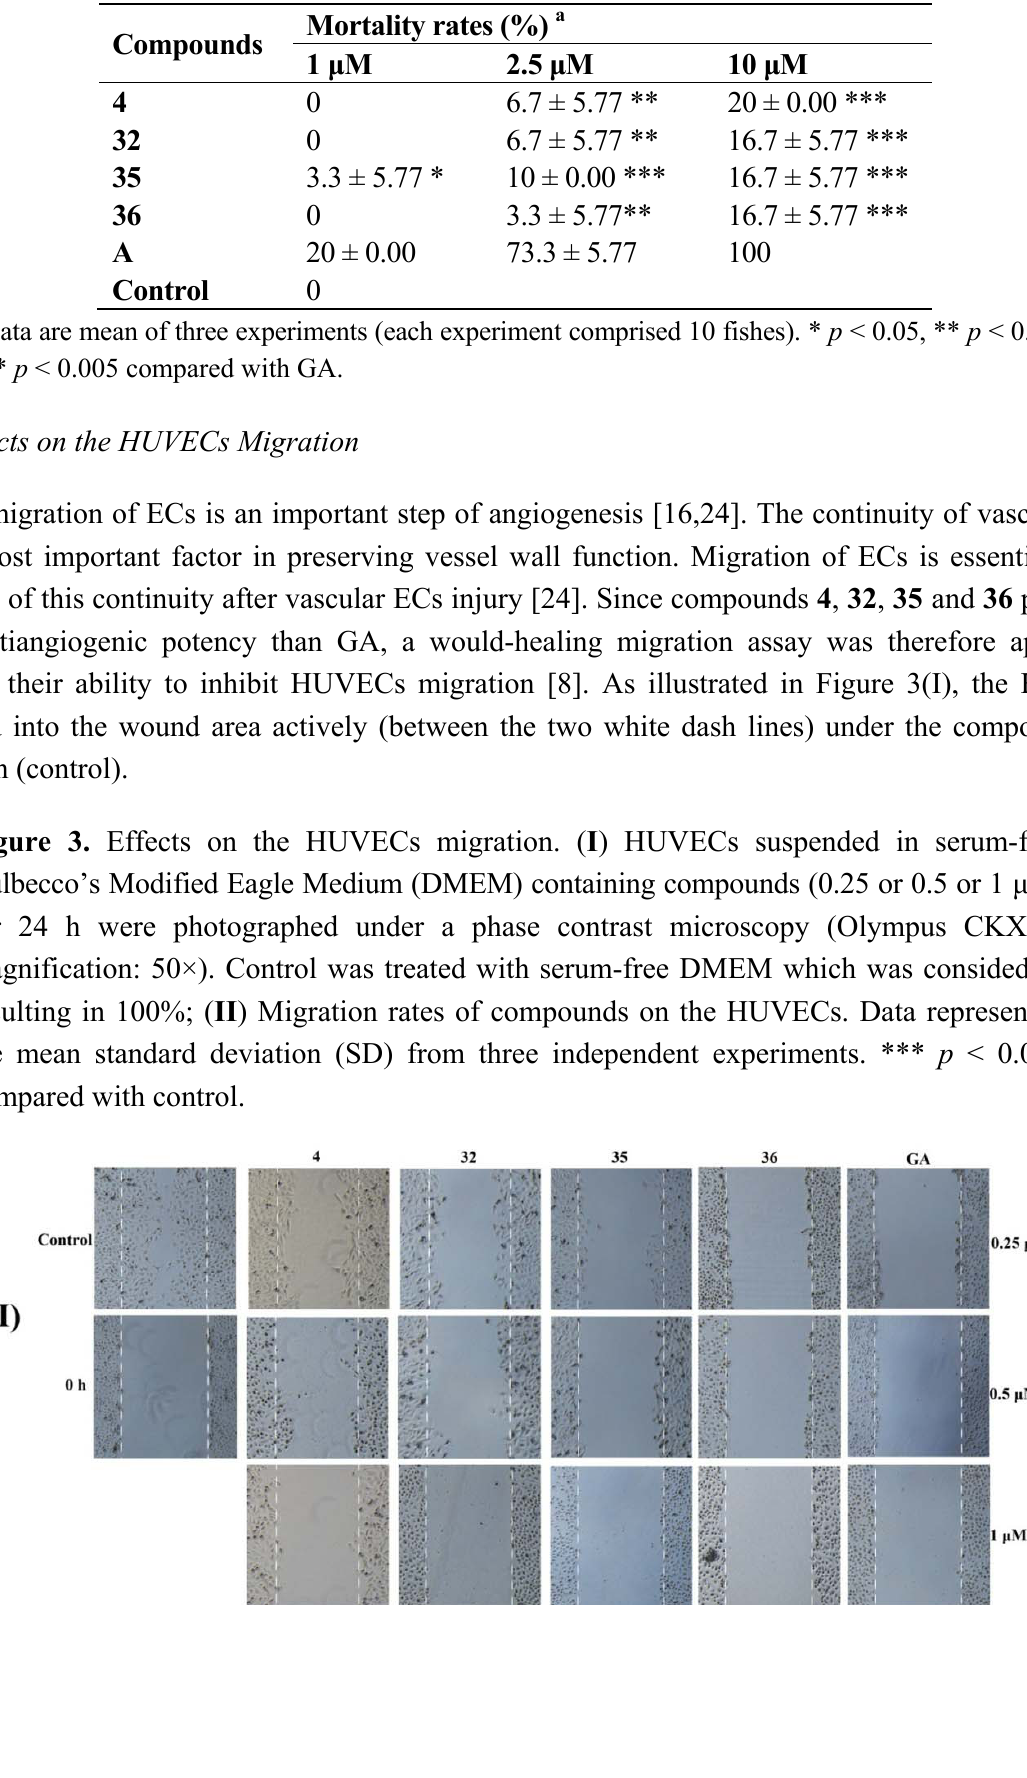
Table 3. The effects of 4 , 32 , 35 , 36 on the zebrafish mortality